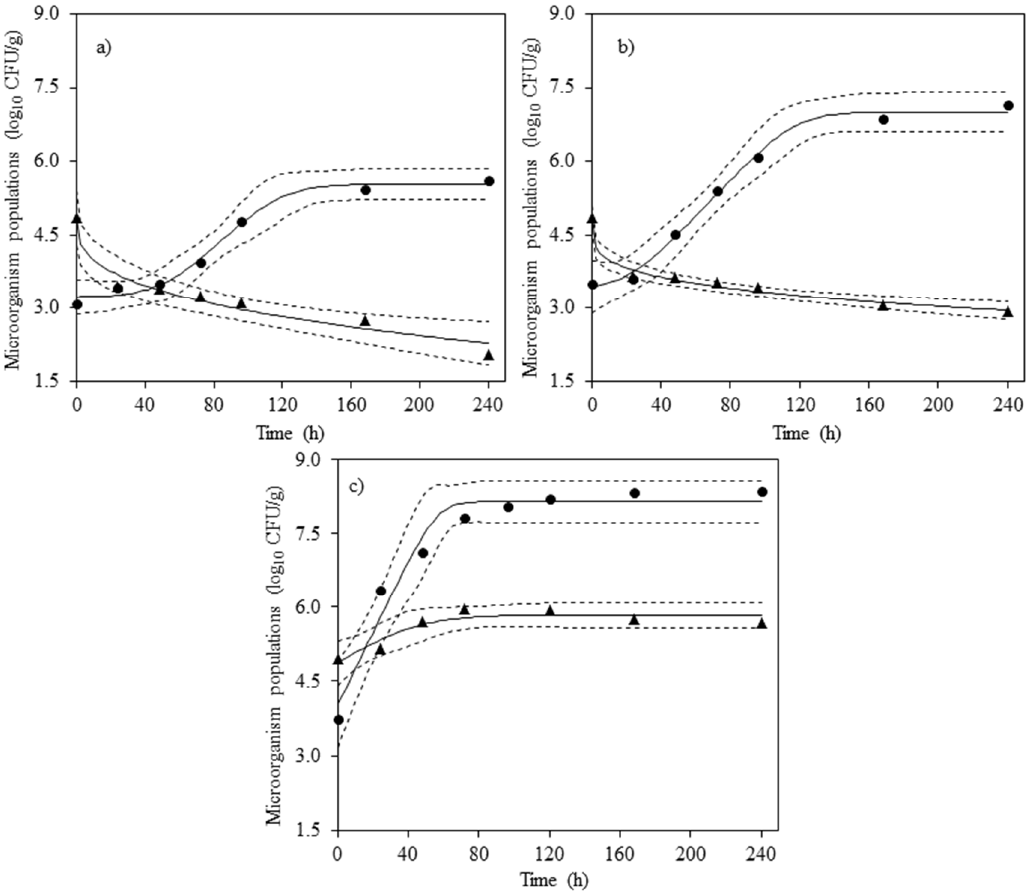
Figure 1. Experimental data of lactic acid bacteria ( ● ) and Salmonella Reading ( ▲ ) obtained on fresh ‐ cut iceberg lettuce stored at 4 °C ( a ), 8 °C ( b ) and 15 °C ( c ). The solid (—) and dashed ( ‐ ‐ ‐ ) lines show the fitted values and their confidence bands at 95%, respectively.